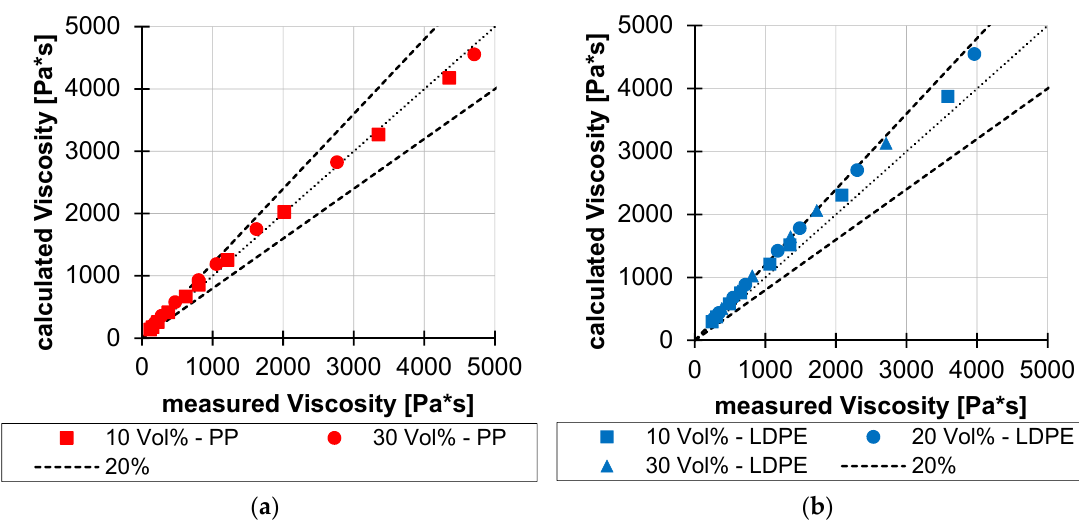
Figure 11. Comparison of measured and calculated viscosities of PP ( a ) and LDPE (b).